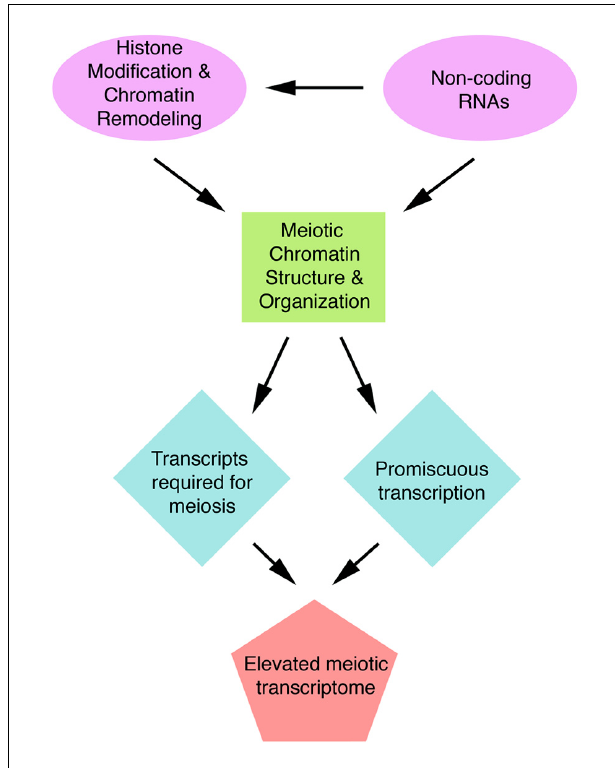
FIGURE 3 |A diagram showing potential mechanisms that could affect the meiotic